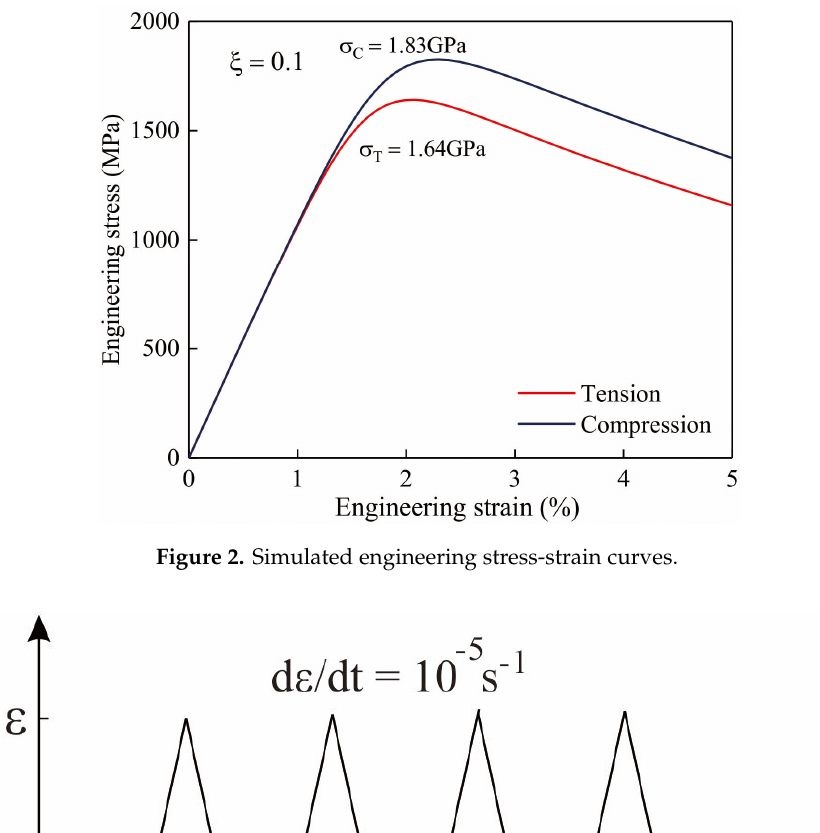
Figure 2. Simulated engineering stress-strain curves.